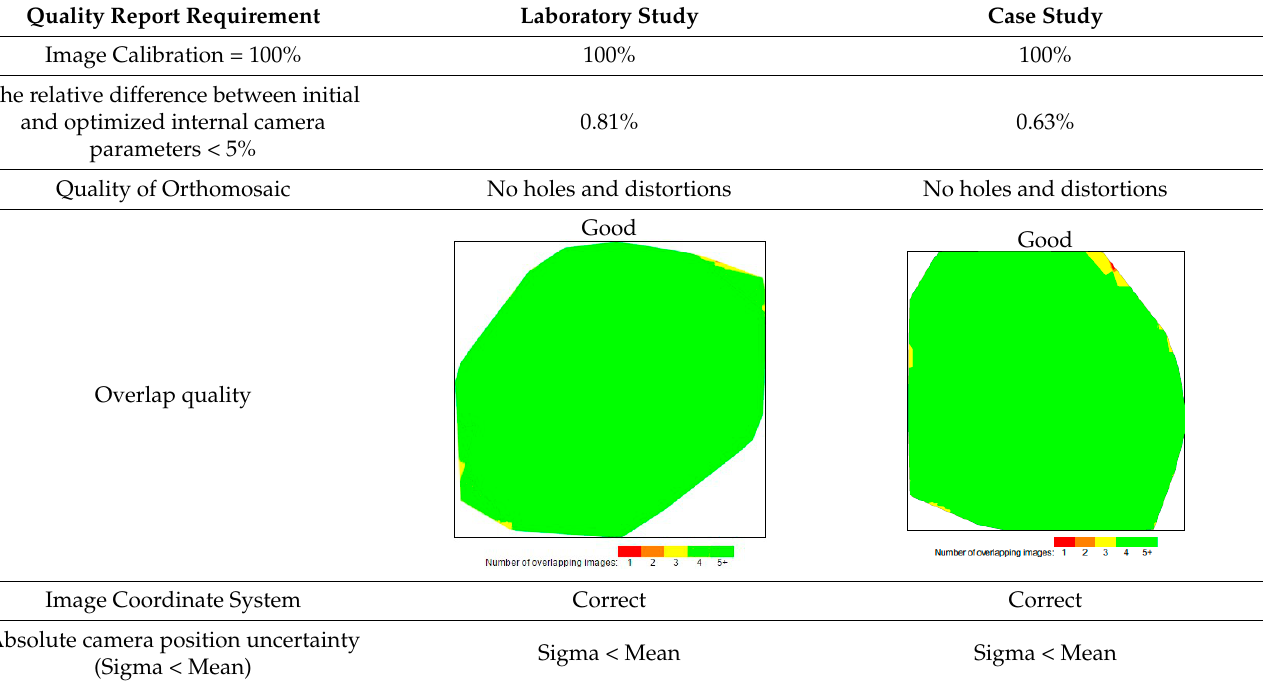
Table 6. Results from the Quality Report of Laboratory and Quarry Site.